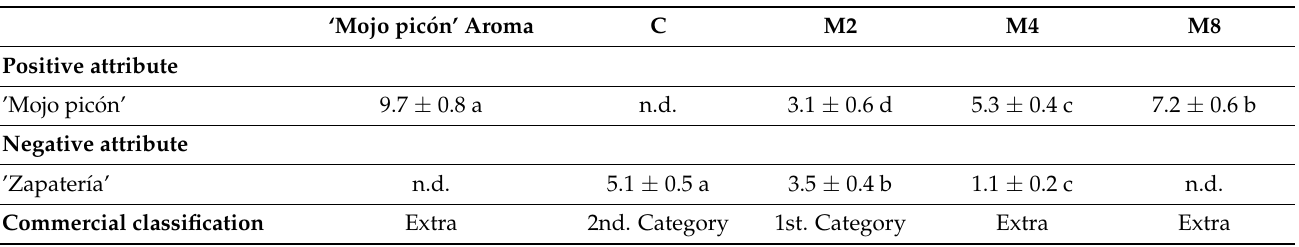
Table 1. Predominantly perceived sensory defects (mean ± standard deviation) of Spanish-style table olives stuffed with flavoured hydrocolloids. Different lowercase letters indicate statistically significant differences according to the intensity of the added flavour between each treatment (Tukey’s Test, p -value < 0.05).